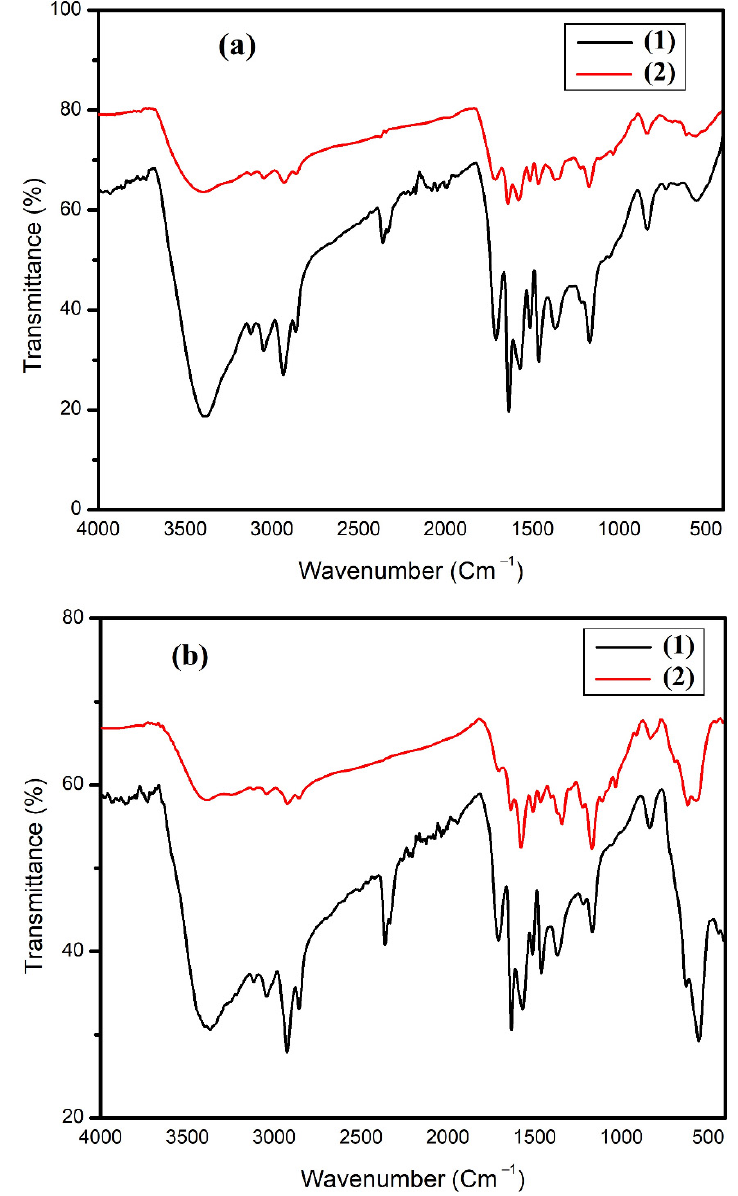
Figure 1. FTIR spectra of ( a ) CQVP/MA and ( b ) CQVP/MA-Fe 3 O 4 before (1) and after (2) dye re- moval.